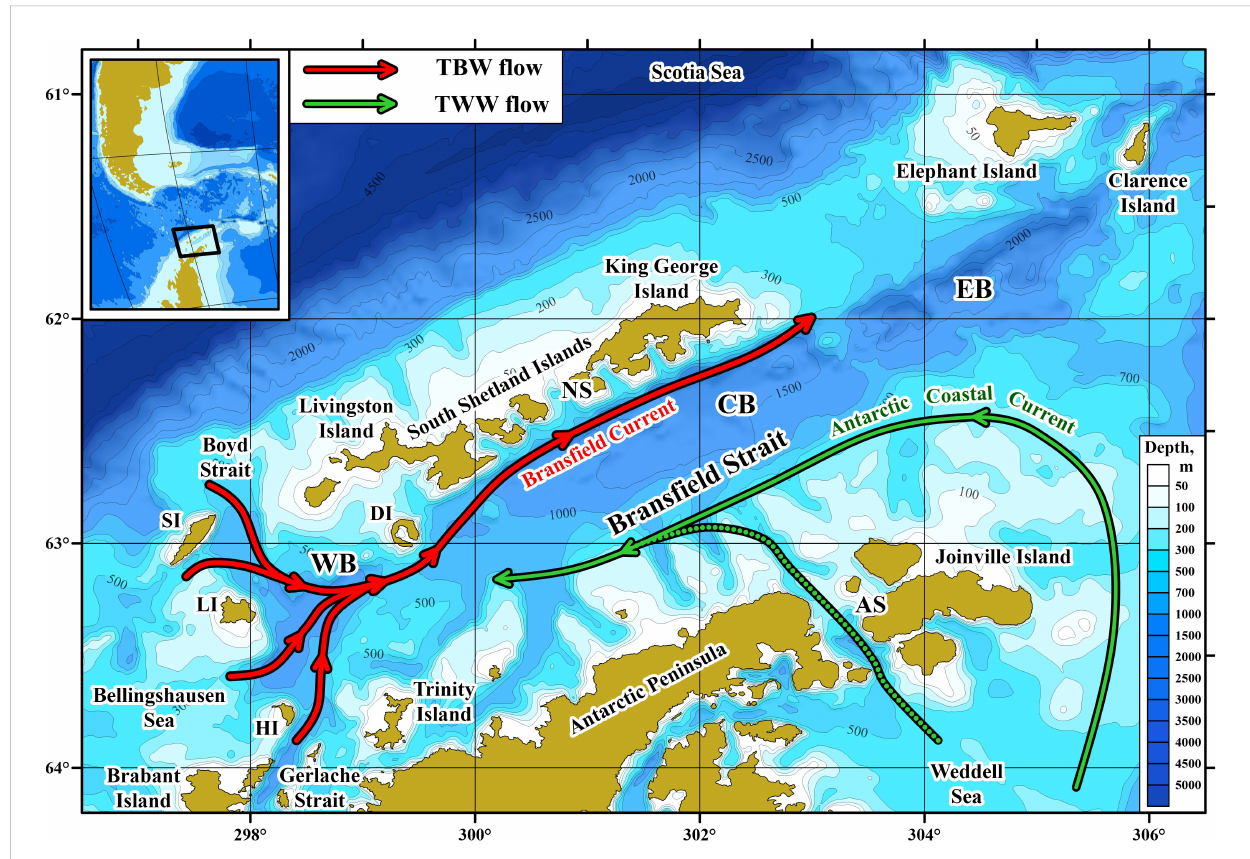
FIGURE 1 Schematic of mean surface circulation in the Brans fi eld Strait. The Brans fi eld and Antarctic Coastal currents are shown by red and green arrows, respectively. A green dotted line indicates possible in fl ow from the Weddell Sea to the strait (Sangrà et al., 2011). The bathymetry source is the GEBCO2019 database; the shoreline is shown according to the GSHHS data (Wessel and Smith, 1996). WB, Western Basin; CB, Central Basin; EB, East Basin of the Brans fi eld Strait; DI, Deception Island; SI, Smith Island; LI, Low Island; HI, Hoseason Island; NS, Nelson Strait; AS, Antarctic